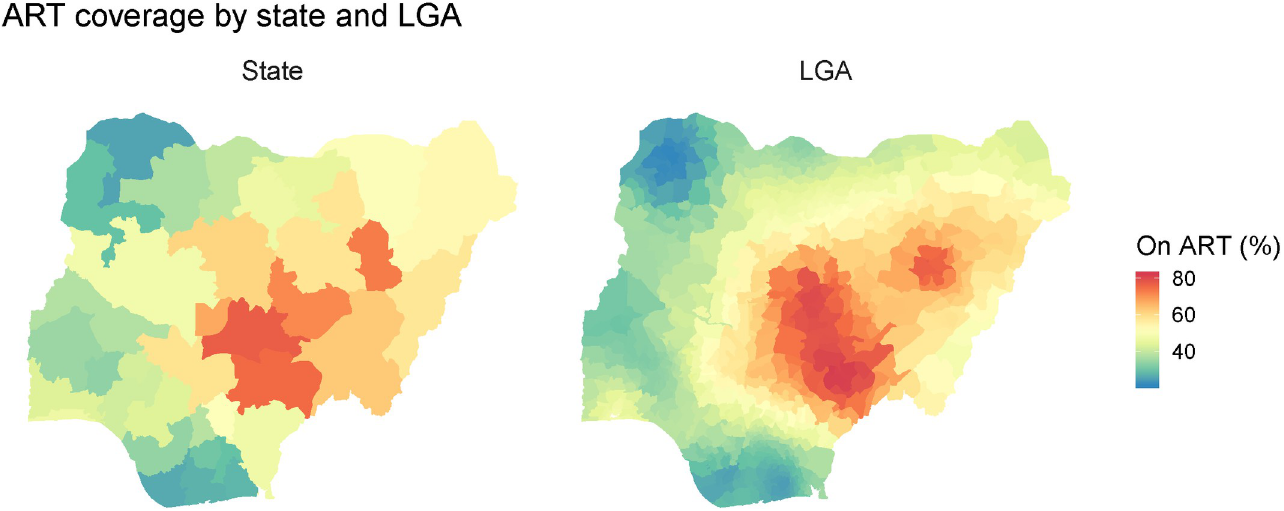
Fig 2. Estimated antiretroviral therapy coverage by state and local government area (n = 774) in Nigeria (2018).